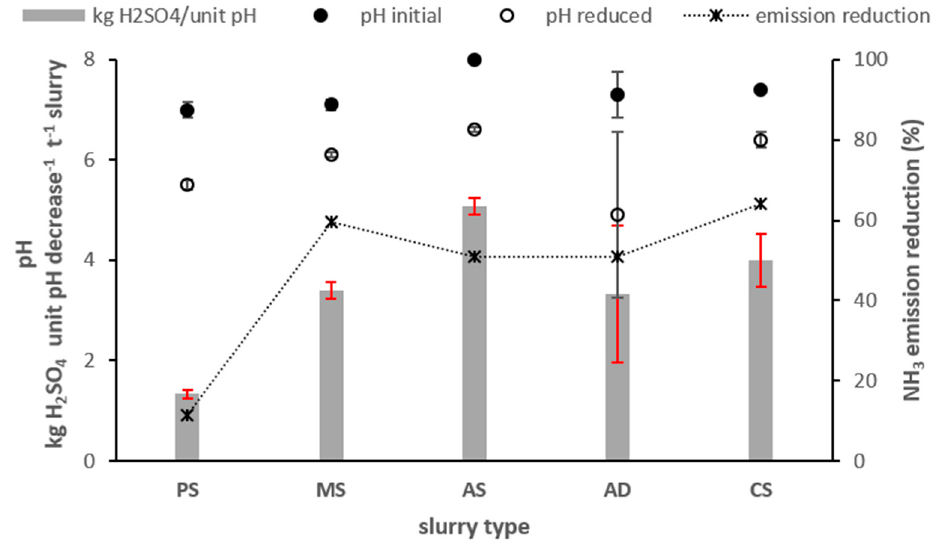
Figure 4. NH 3 loss after application of five different slurries with and without acidification by trail hoses, second winter wheat trial. Applied NH 4+ ‐ N ha − 1 CS = 84.8 kg, AD = 79.5 kg, MS = 78.75 kg, PS = 84.42 kg, and AS = 79.5 kg, n = 4; mixed effects model, HSD test p < 0.05, n = 4; lowercase letters indicate significant differences between treatments; CS, cattle slurry; A, anaerobic digestate; MS, mink slurry; PS, pig slurry; AS, liquid phase separated A; ac, acidification.